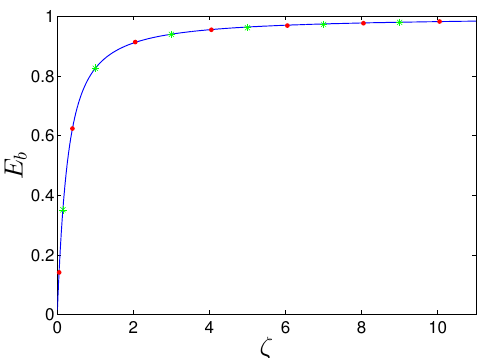
Figure 4. The surface energies versus the boundary parameters. The blue curves are the ones calculated from equation (4.7), while the red points ( ξ = − 0 . 1, θ = π/ 5, φ = 0, θ ′ = 0 and φ ′ = 0) and green stars ( ξ = − 5, θ = π/ 4, φ = 0, θ ′ = 2 π/ 3 and φ ′ = 0) are the ones obtained from Hamiltonian (1.1) with the BST